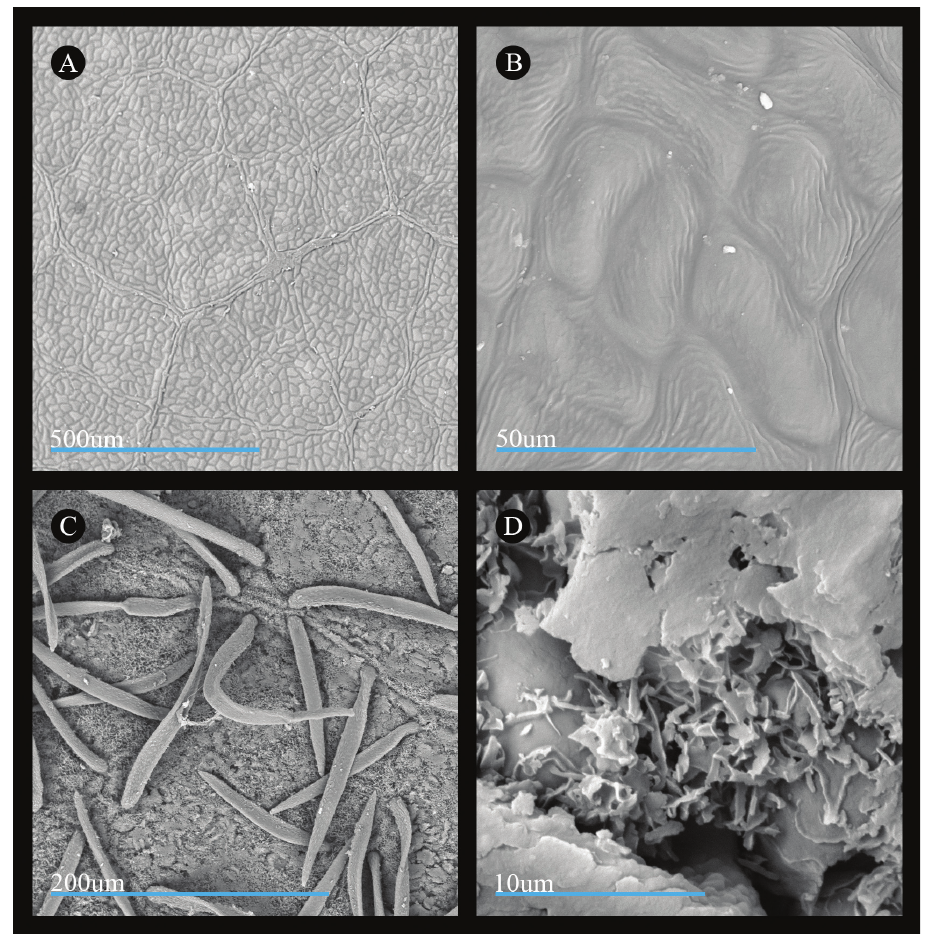
Figure 4. Micrographs of the leaf surfaces of Acer saccharinum . A Adaxial surface showing cell shape and organization ( Norton 69 ) B Adaxial surface showing cuticle ( Richardson & Robertson 915) C Abaxial surface showing cell shape and organization of cells and stomata ( Brown 8023 ) D Abaxial surface show- ing cuticular wax ( Coville s.n. ). All leaf materials are from specimens deposited at US, and parenthetical information in this legend refers to the collector name and